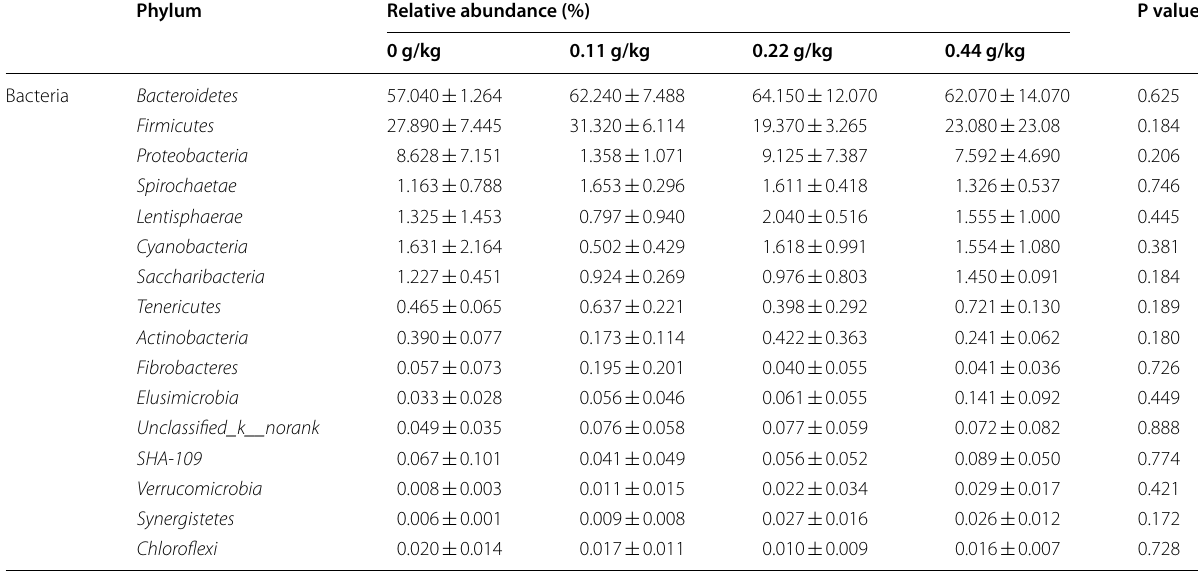
Table 7 Effects of sodium nitrate on average relative abundance of rumen bacterial microbiota (% of total sequences) at the phylum level in water buffaloes (n =